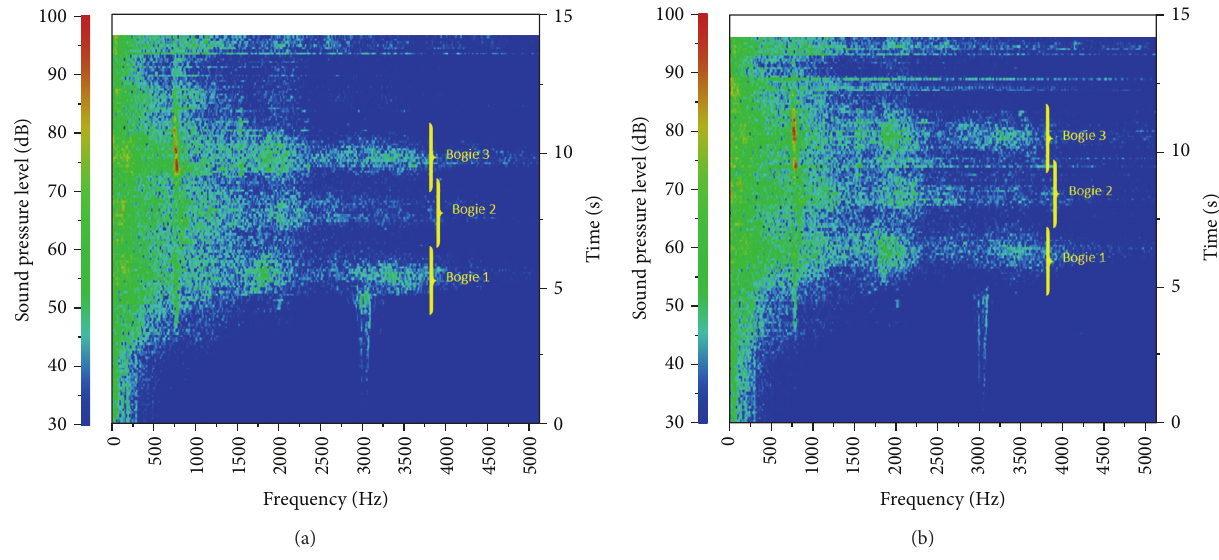
Figure 14: Experimental measurements on track for two different